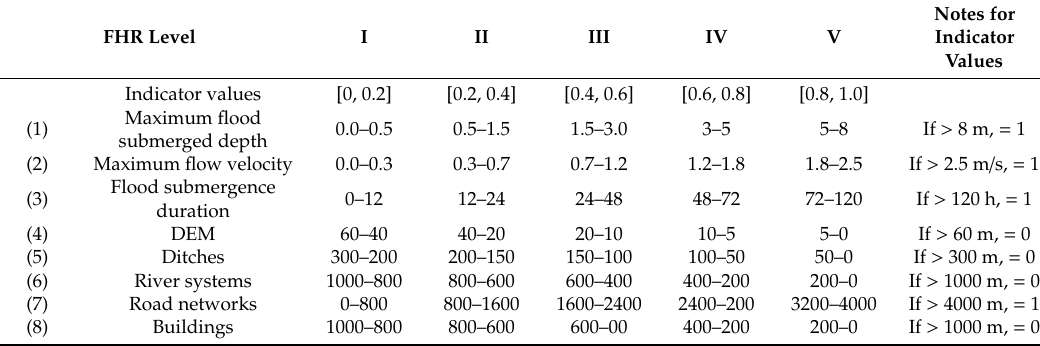
Table 2. Normalization of flood hazard risk (FHR)